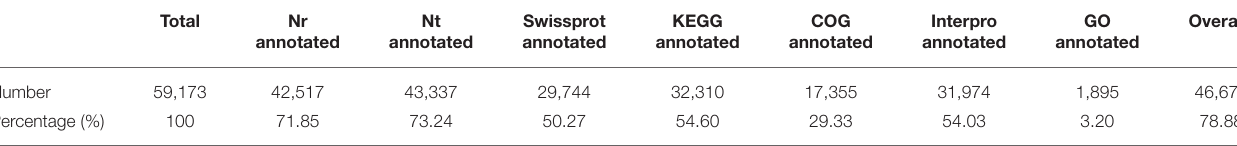
TABLE 2 | Summary of function annotation.